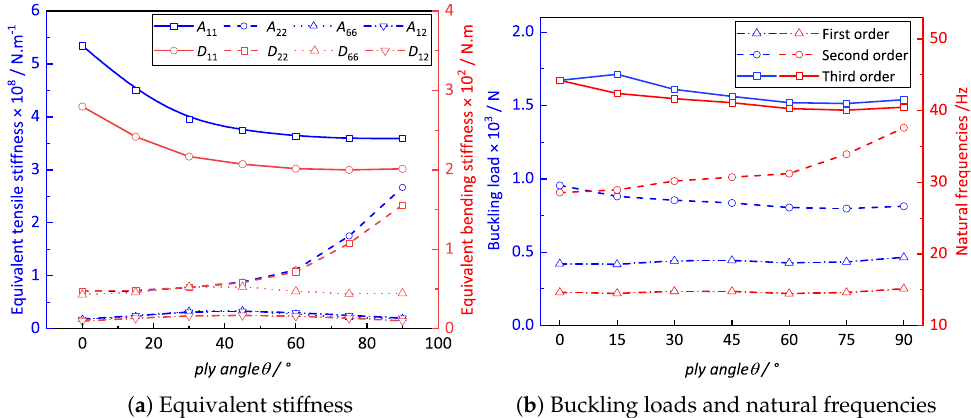
Figure 13. The influence of ply angle on the effective performance of